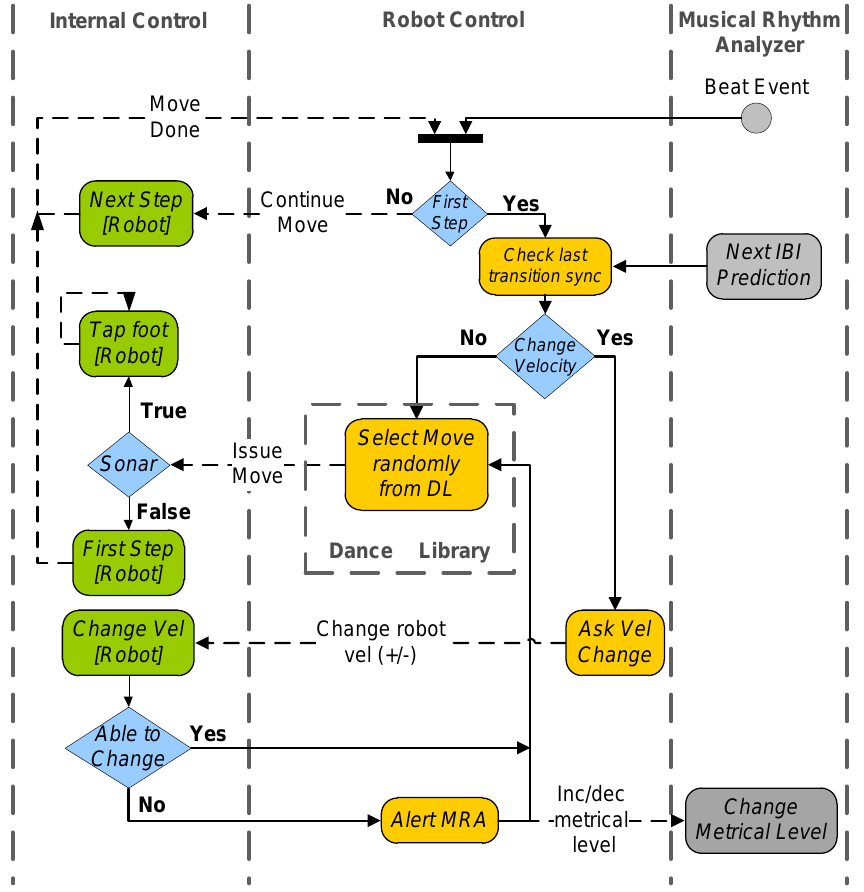
Figure 2: Data-flow of the sensorimotor robot dancing